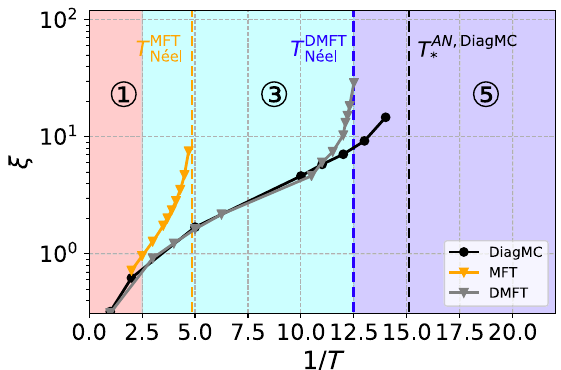
FIG. 8. Spectral function extrapolated to zero frequency at the antinode and node, obtained from the imaginary part of the Green function in DiagMC (solid lines; red circles are for the antinode, and blue triangles are for the node) and DMFT (on the Fermi surface; dashed line with gray